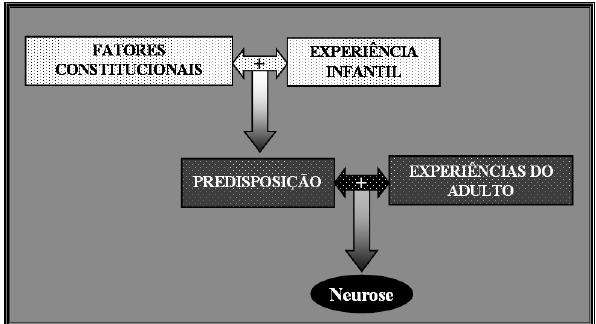
Figura 1 . Ilustração das séries complementares propostas por Freud